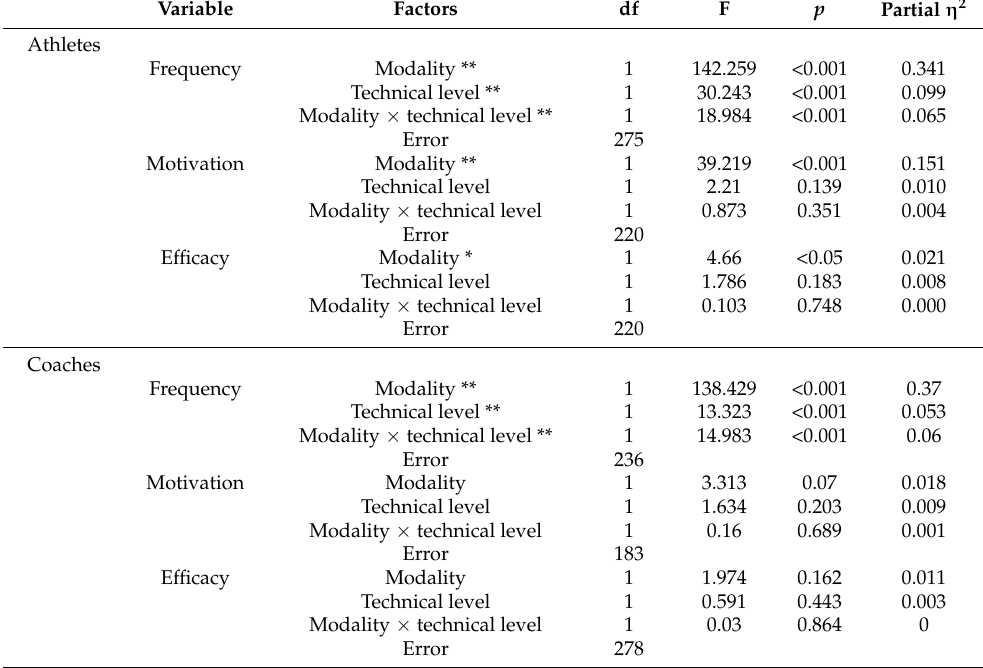
Table 1. ANOVA results for athletes and coaches for the numeric variables of training (frequency, motivation, and efficacy), with technical level (gold vs. silver) as the between-participants factor and online training modality (live streaming vs. pre-recorded) as the within-participants factor.